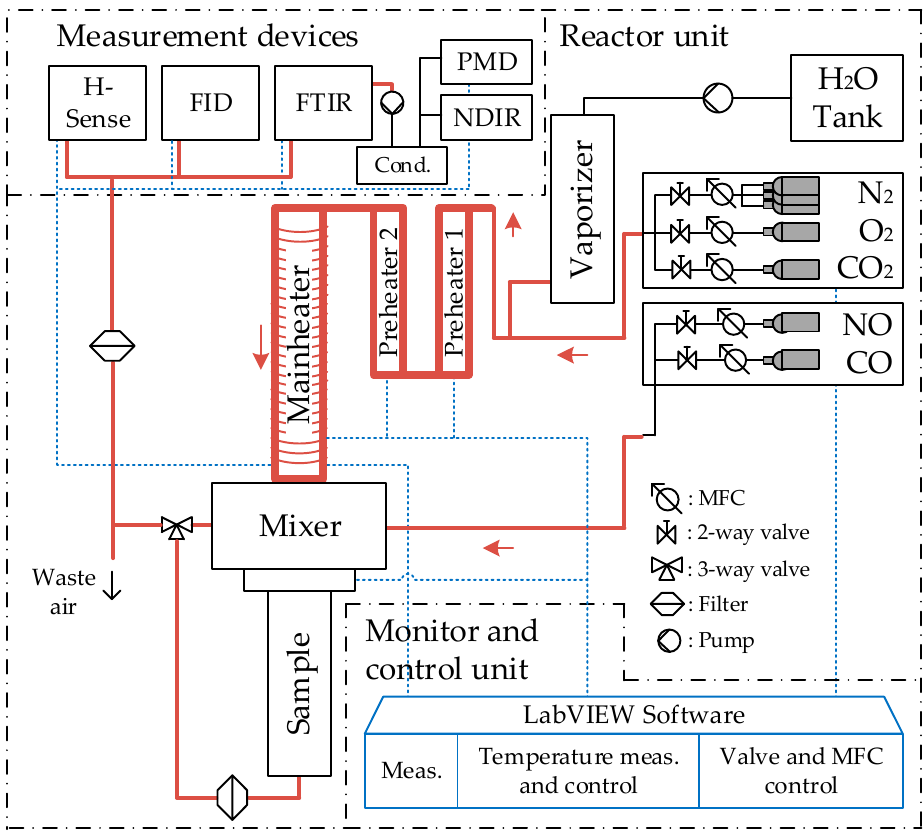
Figure 8. Schematic of the laboratory gas test bench.